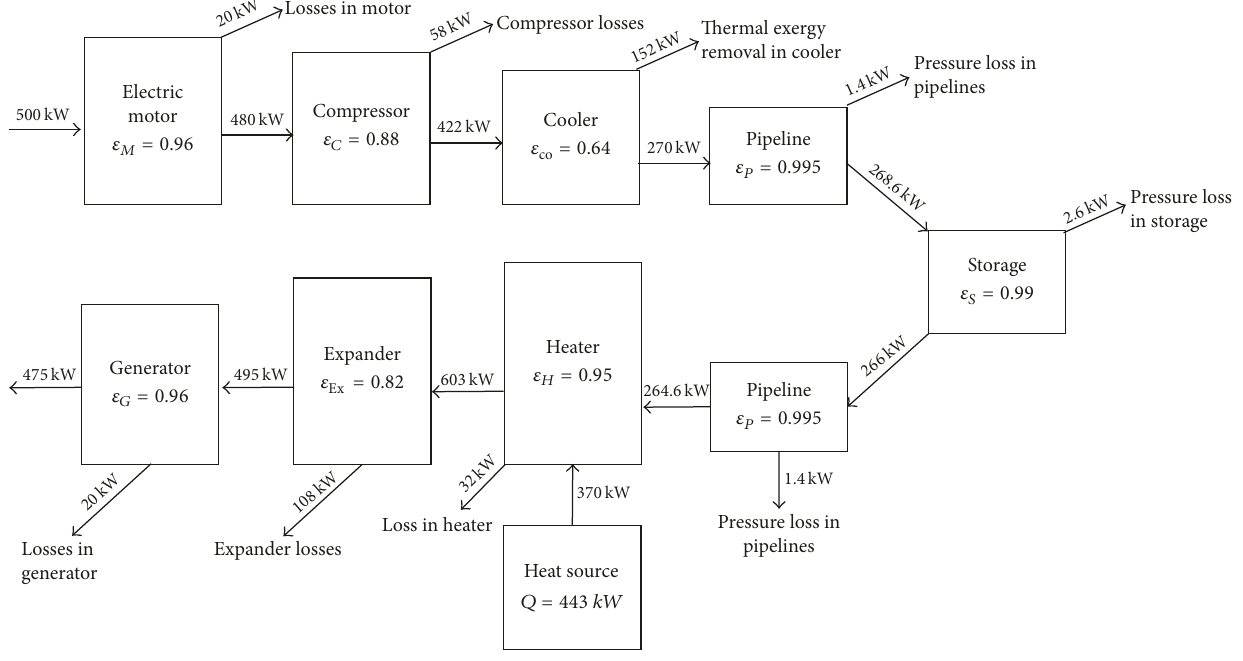
Figure 5: Exergy flow in diabatic OCAES.